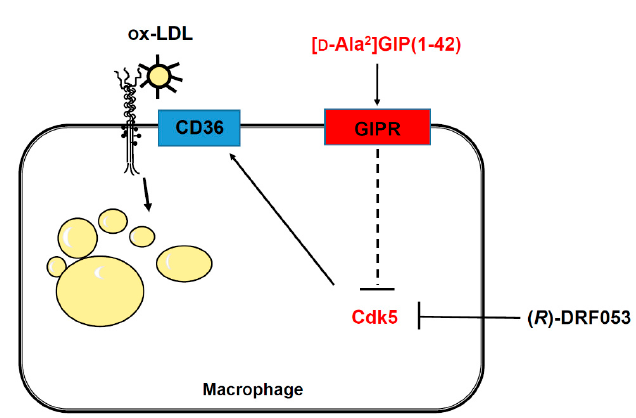
Figure 3. Possible mechanisms how [D-Ala 2 ]GIP(1–42) could inhibit foam cell formation of phages. [ D -Ala 2 ]GIP may suppress macrophage foam cell formation through the transcriptional in- macrophages. [D-Ala 2 ]GIP may suppress macrophage foam cell formation through the transcrip- tional inhibition of CD36 via Cdk5 pathway. GIP, glucose-dependent insulinotropic polypeptide; GIPR, receptor of glucose-dependent insulinotropic polypeptide; Cdk5, cyclin-dependent kinase 5; ox-LDL, oxidized low-density